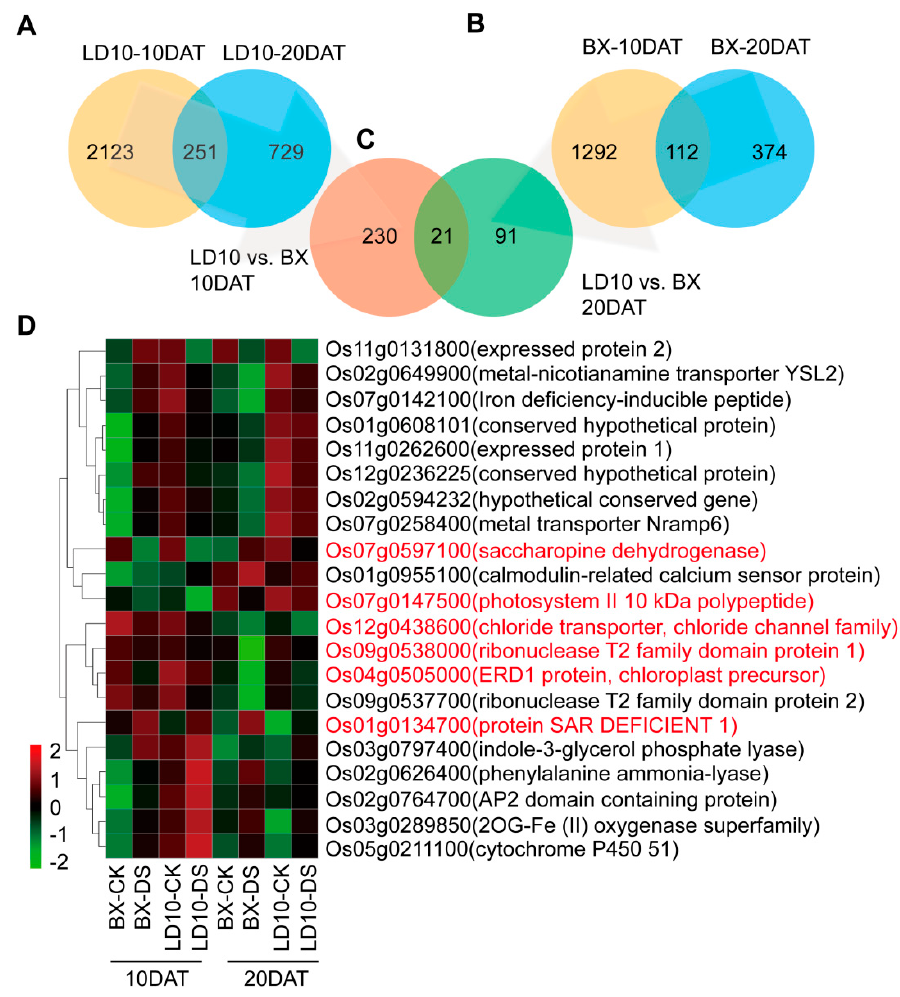
Figure 6. Six drought-responsive genes of interest identified in two rice accessions over two stages. ( A , B ) Venn diagram representing overlapped genes in LD10 ( A ) and BX ( B ) between the two stages for each rice accession. ( C ) Overlapped genes in LD10 and BX across the two stages. ( D ) Heatmap representing the 21 overlapped genes for drought-responsive genes.